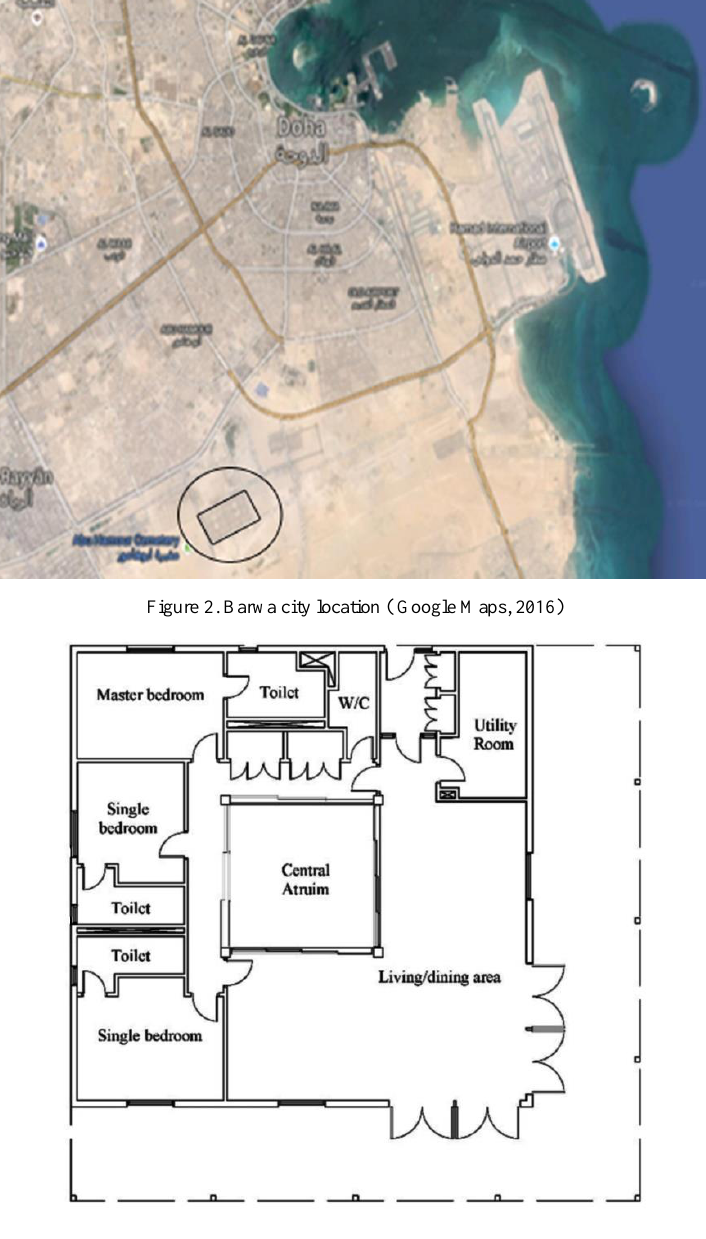
Figure 3. PHV and STV typical